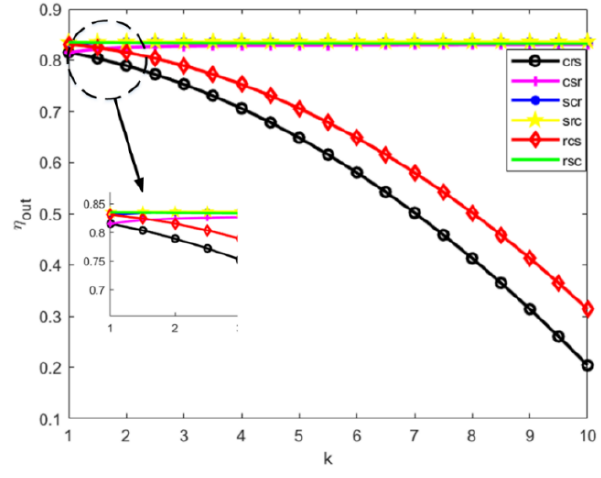
Figure 4. Efficiency graph of different layouts.